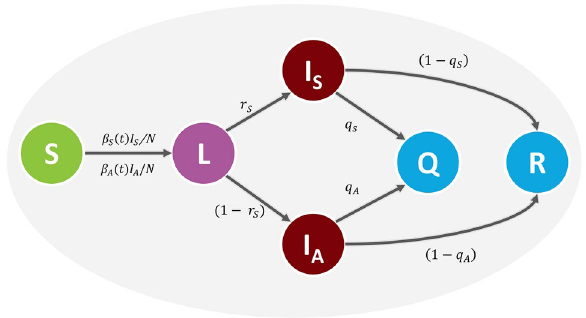
Figure 7. Schematic of the COVID-19 transmission model. The model comprises six epidemiological compartments: susceptible (S), latently infected (L), symptomatic infectious (I S ), asymptomatic infectious (I A ), quarantined (Q), and recovered (R).